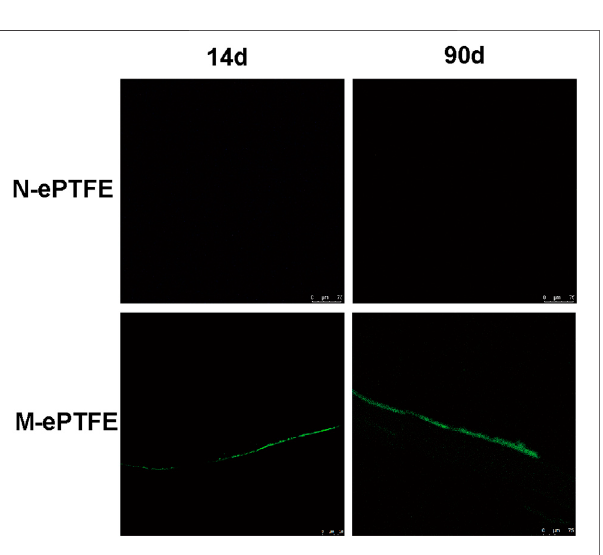
Frontiers in Bioengineering and Biotechnology |